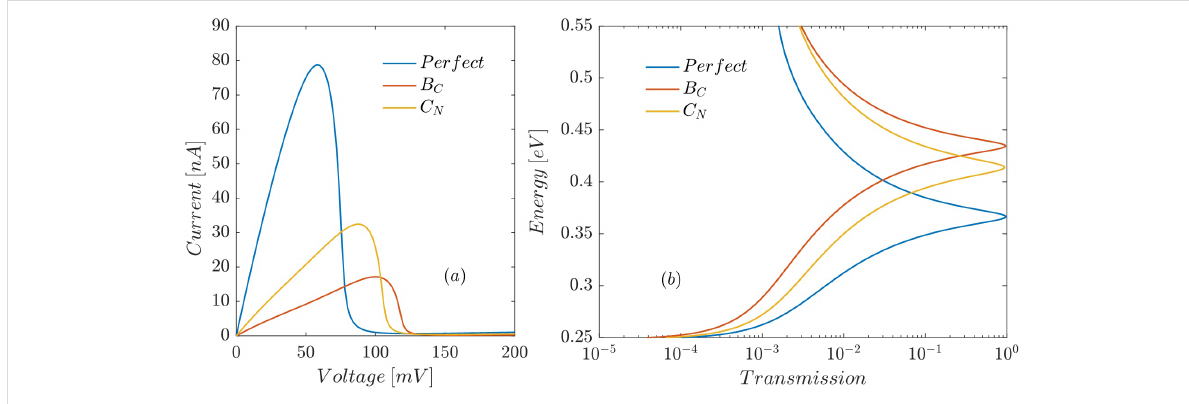
Figure 5: Effect of B C and C N defects at the interface between the right barrier and the well on (a) current–voltage characteristic and (b) the transmis- sion trough the proposed RTD as a function of the electron energy.